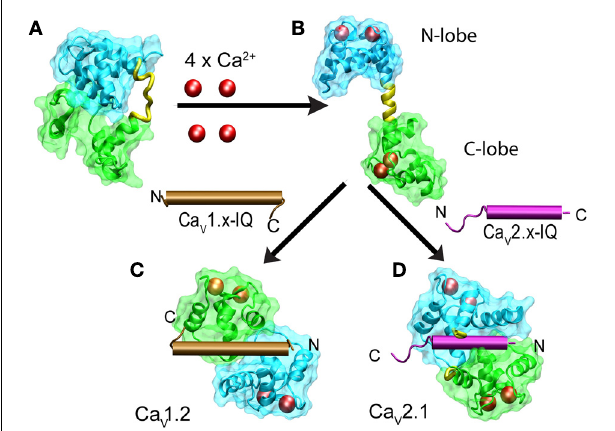
FIGURE 6 | Structural changes of calmodulin upon binding to Ca 2 + and IQ in Ca V 1.x and Ca V 2.x channels. The N- and C-lobes of CaM are shown in cyan and green, respectively while the linker is colored in yellow. Ca 2 + ions are represented as red spheres and IQ as brown and violet cylinders for Ca V 1.x and Ca V 2.x, respectively. Binding of four Ca + 2 to the dumbbell-like configuration of ApoCaM (A) promotes the extended conformation of CaM with an α -helical linker (B) . Binding of Ca 2 + -CaM to IQ brings the N- and C-lobes into close proximity. IQ from Ca V 1.x binds to CaM in a parallel configuration (C) and IQ-Ca V 2.x in an antiparallel manner (D) . PDB files are as follows: apoCaM: 1QX5, free Ca 2 + CaM: 1CLL, CaM with Ca V 1.2 IQ: 2BE6, CaM with Ca V 2.2 IQ 3DVE, dimer CaM with Ca V 1.2 IQ: